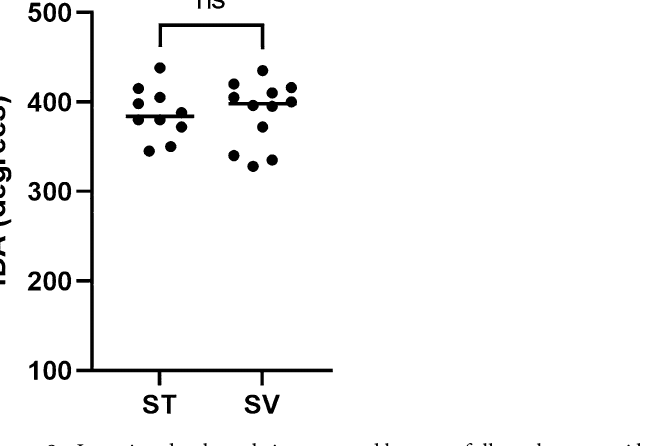
Figure 9. Insertion depth angle is compared between fully scala tympani located arrays and arrays with at least one electrode in scala vestibuli. All insertion depth angles were plotted of arrays with the stop electrode within 2 mm distance from the CO or RW site (n = 22). Median of both groups are shown. IDA insertion depth angle, CO cochleostomy, RW round